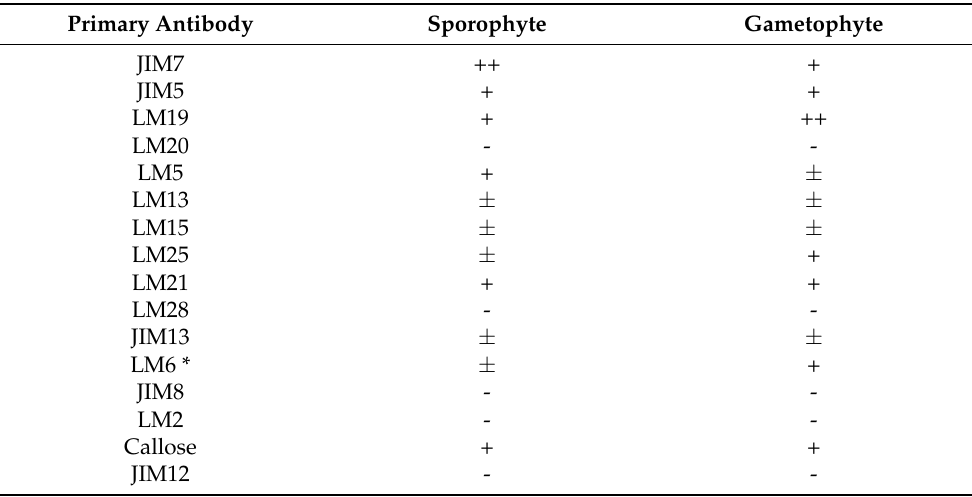
JIM8 - - LM2 - - Callose + + JIM12 -